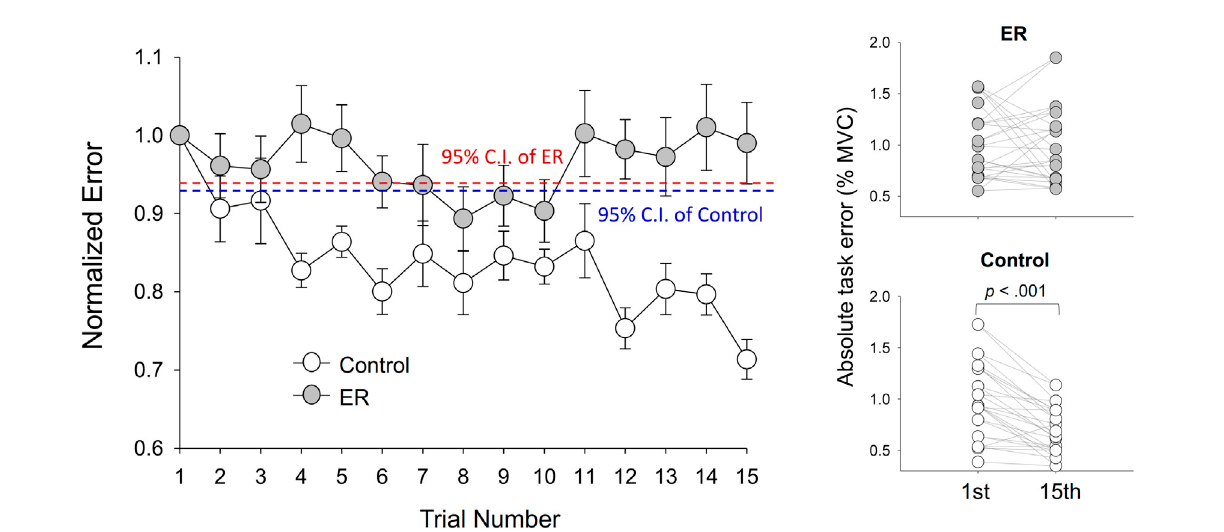
FIGURE 3 Evolutional changes in normalized task errors during the training session for the ER and control groups. The control group showed a decreasing trendofnormalizederrorsacrosstraining sessions.Absolute taskerrorwasdenotedastheRMSvalueofthemismatches betweenthetargetand tracking force (% MVC). (95% CI: 95% con fi dence interval of the pre-test task error normalized with task error of the fi rst trial).